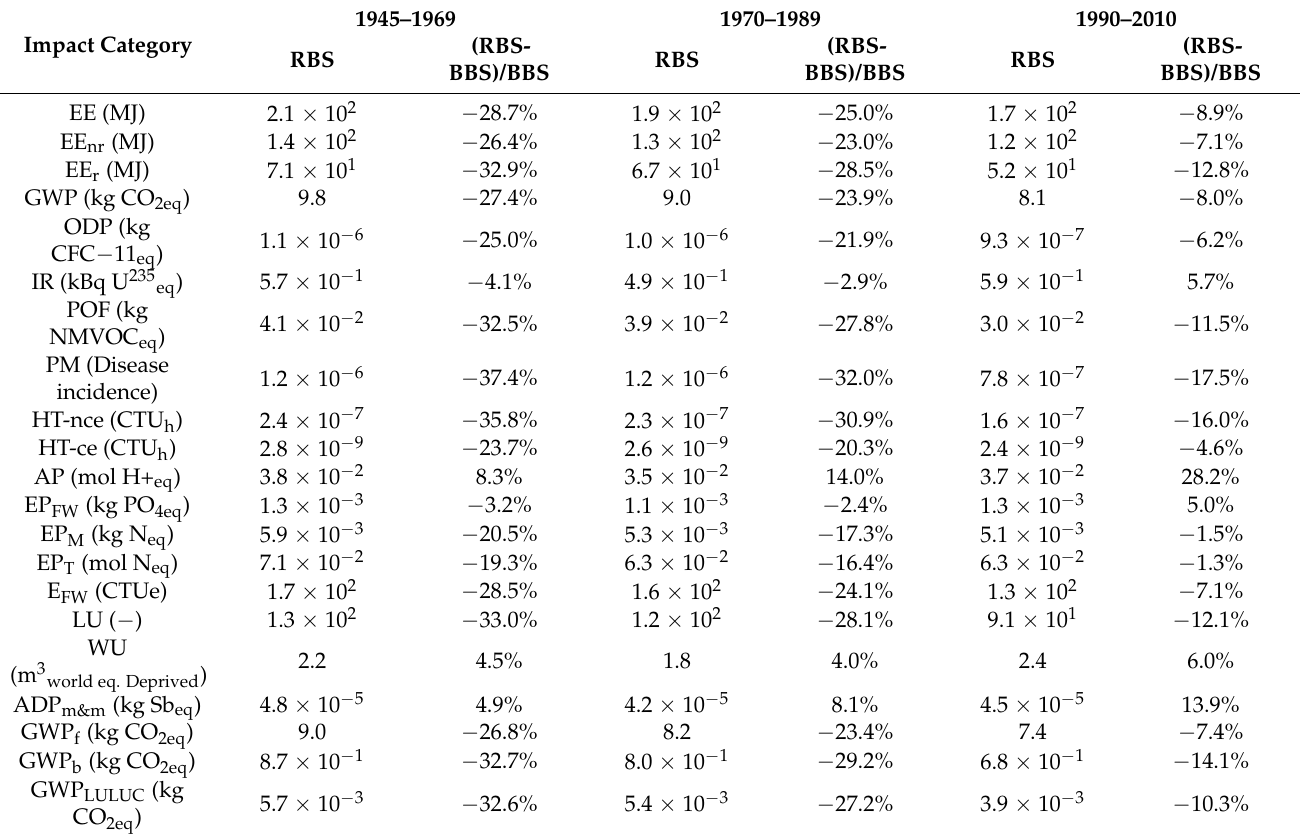
Table 5. LCIA—expanded system boundaries—cellulose fibers scenarios (FU ES : 1 m 2 of walkable floor per year). Impact